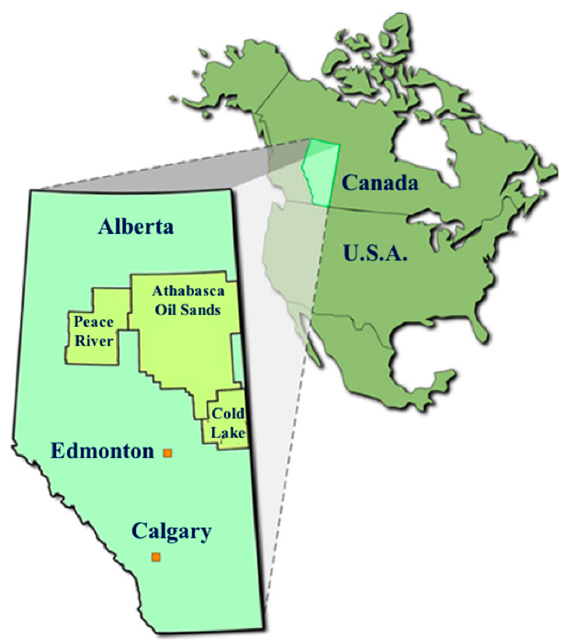
Figure 1. Location of the Athabasca, Cold Lake and Peace River Oil Sands in Alberta [4]. Slotted liners have been extensively used in Western Canada for heavy oil recovery in SAGD operation. Sanding, inflow resistance and cost have become the main considerations in slotted liner design. These main factors determine the competing factors of slotted liner: (1) The slots must be narrow enough to retain formation sands; and yet (2) wide enough to minimize flow resistance/impairment. It has been proven that plugging plays a critical role in slotted liner’s damage [6,7]. Plugging in slotted liner can be attributed to two main mechanisms: (1) Pore plugging, in which the pore throats in the porous media are plugged by migrated fines, clays or other byproducts; and (2) slot plugging, which is defined as the reduction in the slot open area, due to trapped sands and production decline, as well as the increase in drawdown pressure.